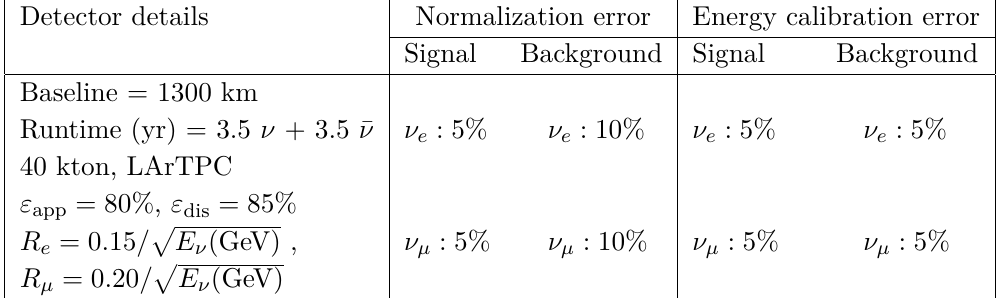
and ε are signal efficiencies for ν CC and ν CC respectively. Also, R app dis e µ and ν CC events respectively. One year of runtime corresponds to e µ